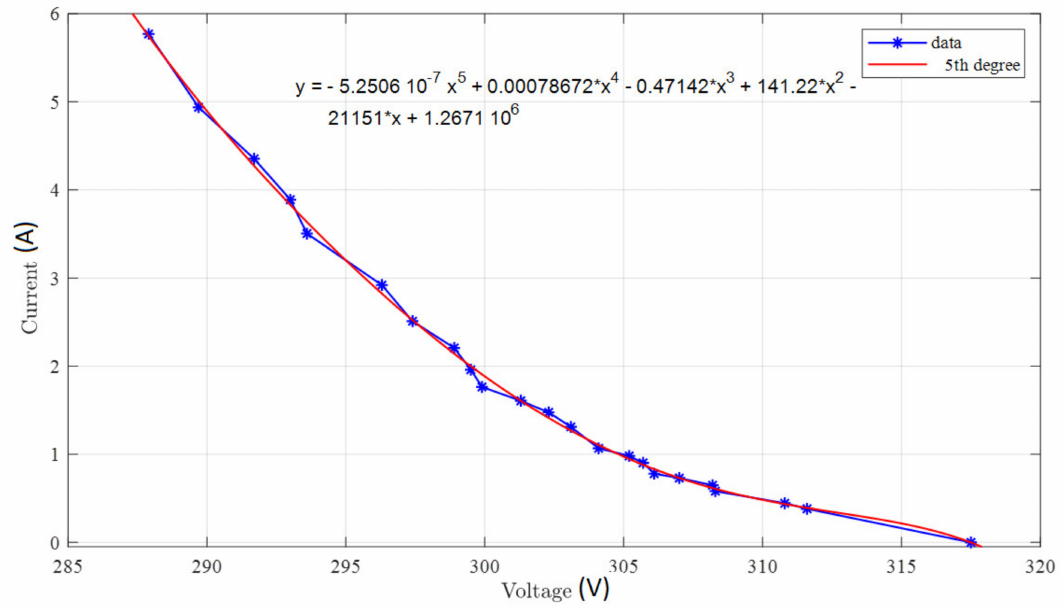
Figure 9. Recorded V / I characteristic of the experimental DC